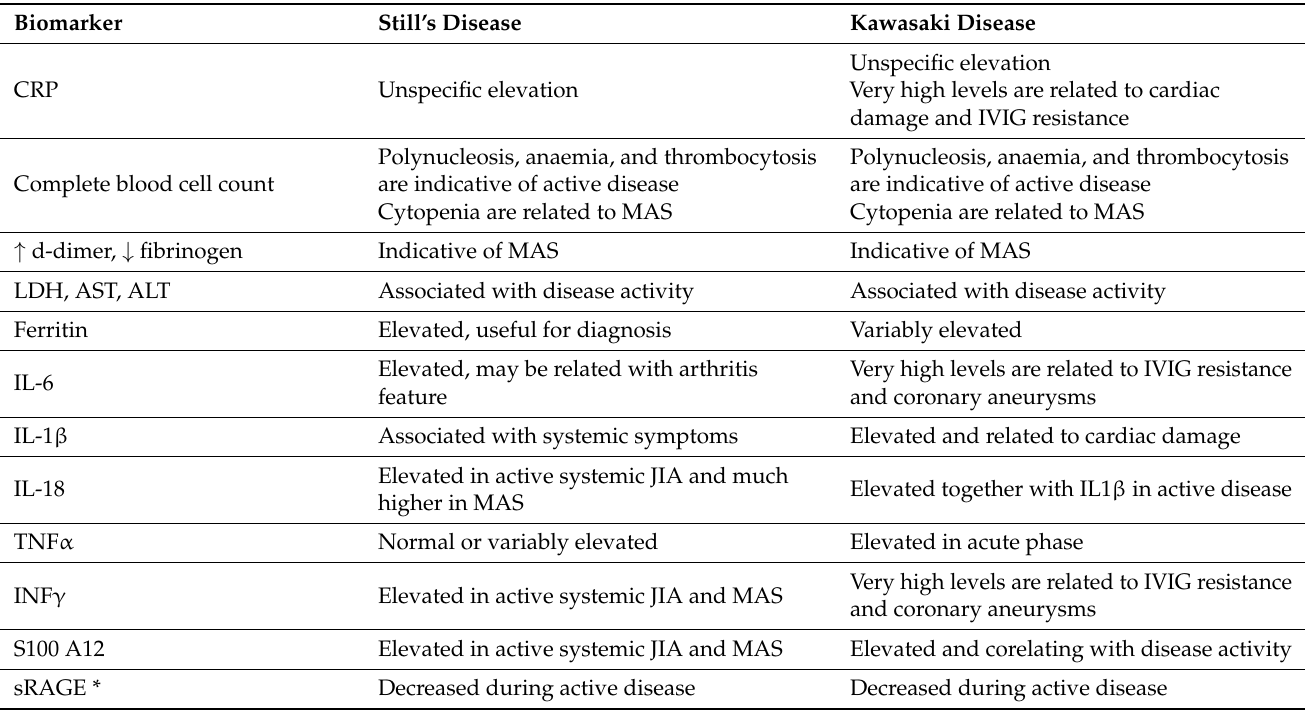
Table 2. Biomarkers associated with disease activity in Still’s disease and Kawasaki disease and those associated with coronary aneurysms in Kawasaki disease